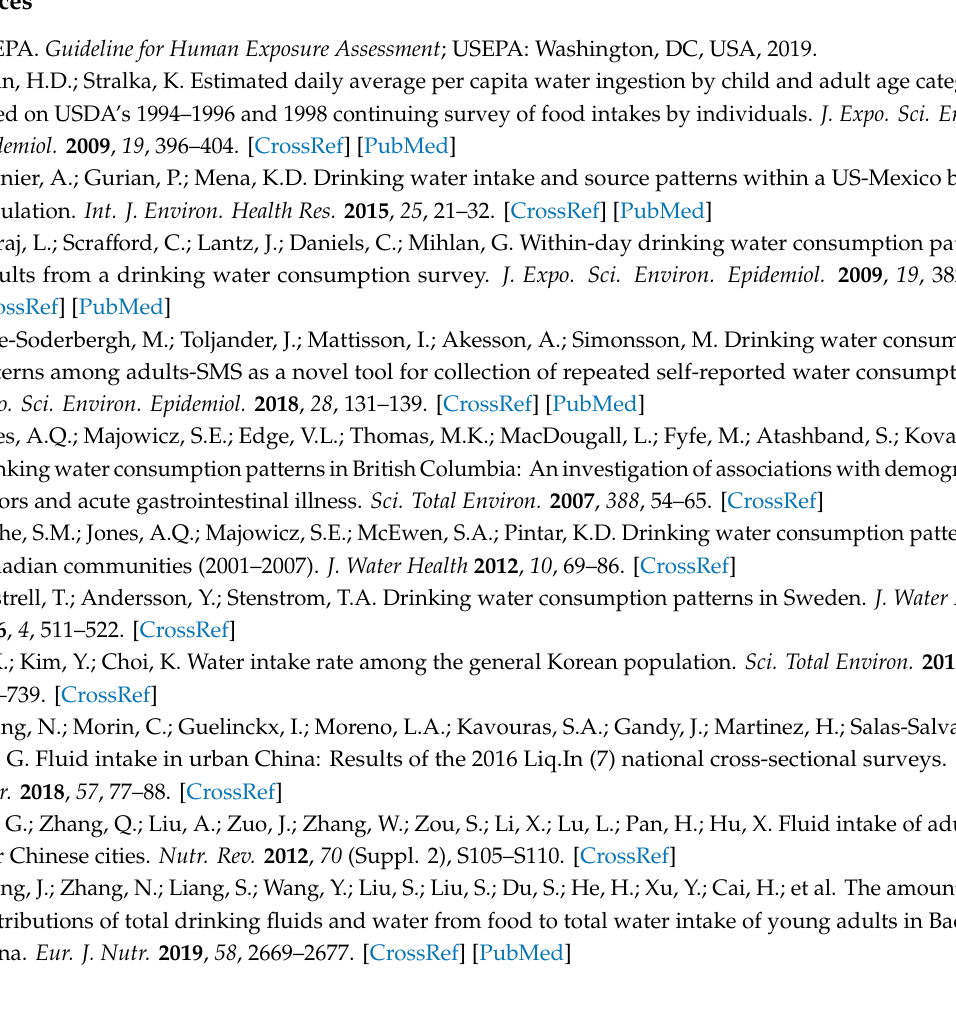
Figure S1: Description of the multiple-stage random sampling method in the study. Table S1: Details of the questionnaire in the study. Table S2: Percentage of water content for the staple food in the study. Table S3: Water consumption of the adults for repeated measures in summer and